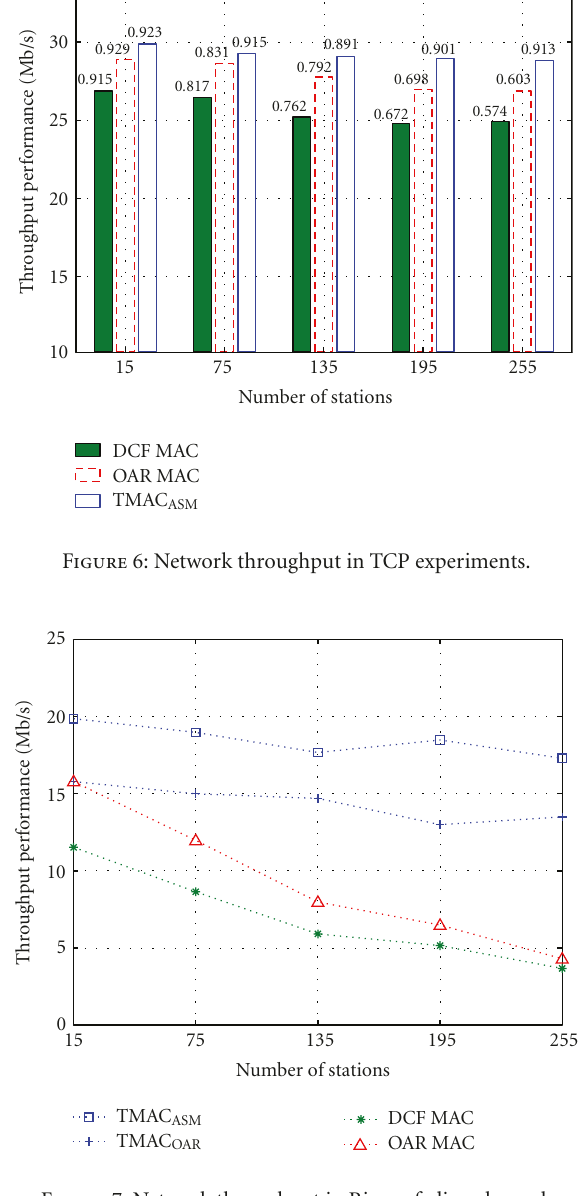
Figure 7: Network throughput in Ricean fading